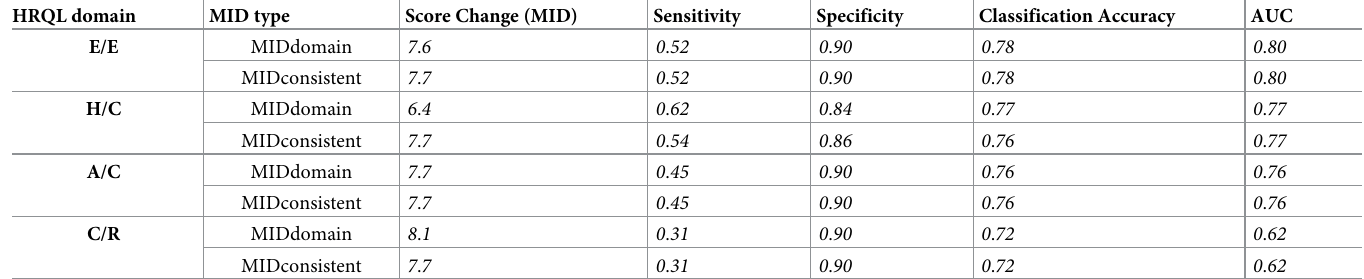
Table 1. Table comparing the sensitivities, specificities, classification accuracy and AUC of each MID for each HRQL domain: ages have been combined but nor- malised